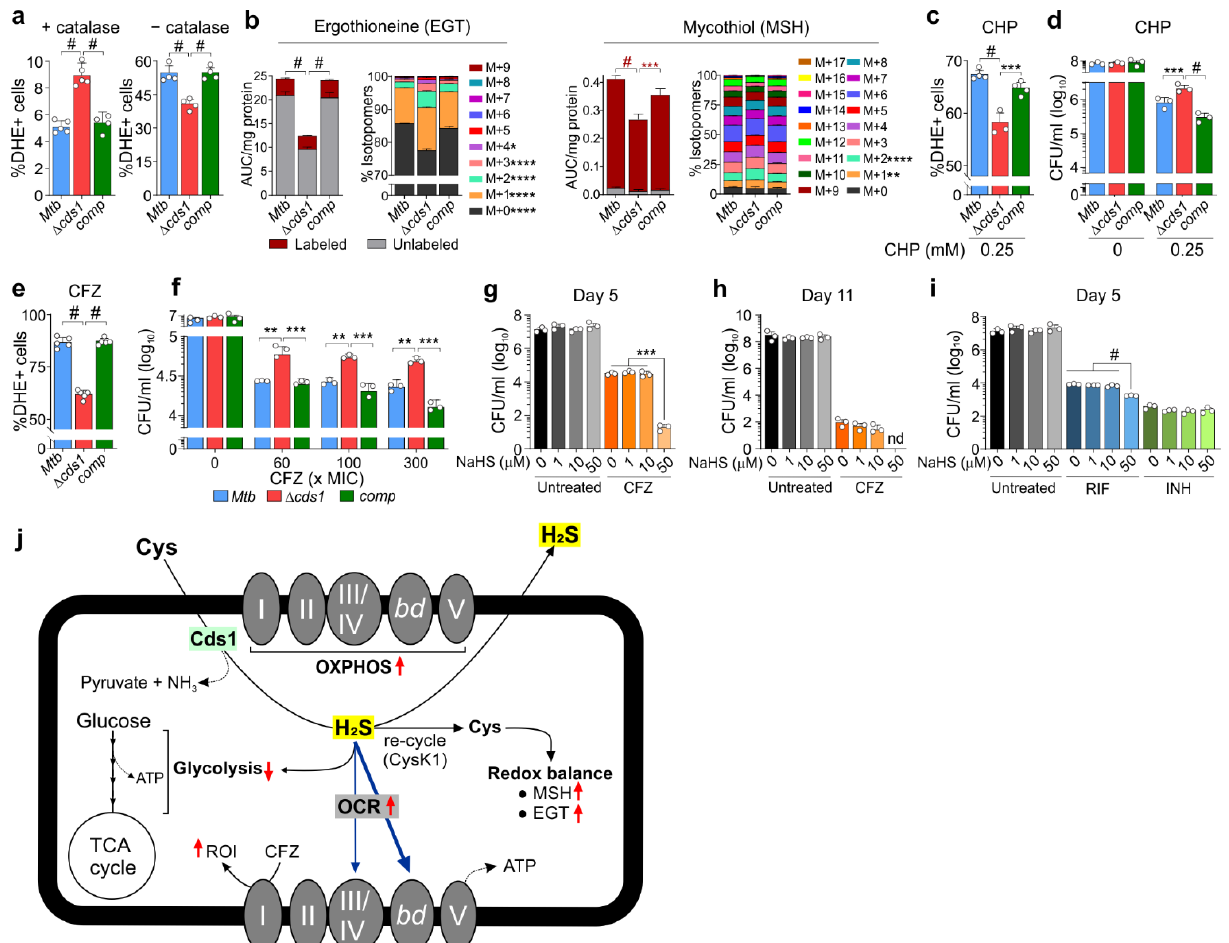
Figure 8. Endogenous H 2 S in Mtb exacerbates the effect of oxidative stress and increases susceptibility to CFZ: ( a ) Intracellular ROI levels shown as the percent of DHE-positive Mtb cultured in 7H9 media supplemented with or without catalase, ( n = 4–5). ( b ) LC-MS/MS analysis showing total abundance and carbon isotopologue distribution of EGT and MSH in Mtb strains cultured in [U- 13 C]-glucose, ( n = 3–5). ( c ) Intracellular ROI levels after exposure to 0.25 mM cumene hydroperoxide (CHP) for 16 h, ( n = 4). ( d ) Survival of bacilli after exposure to 0.25 mM CHP for 16 h, ( n = 3). Bacilli were treated with clofazimine (CFZ) at 60 × MIC and observed for ( e ) ROI levels after 24 h of treatment, ( n = 5) and ( f ) survival after 8 days of treatment, ( n = 3). CFU of Mtb after exposure to different amounts of NaHS with or without 60 × MIC of CFZ for 5 days ( g ) or 11 days ( h ), ( n = 3). ( i ) Survival of Mtb after exposure to different amounts of NaHS with or without RIF (60 × MIC) or INH (60 × MIC) for 5 days, ( n = 3). ( j ) Diagram showing endogenous H 2 S production in Mtb leading to increased respiration (OXPHOS) and suppression of glycolysis. Indicated, also, is recycling of H 2 S to generate Cys, which regulates redox balance via MSH and EGT. Red arrows pointing up: increase; down: decrease. Thick/thin blue arrows: more/less pronounced effects, respectively. Representative experiments are shown; each experiment was repeated at least twice. Data represent the mean ± SD (mean ± SEM for panel ( b )) from the indicated n (number of biological replicates). Statistical analysis and data presentation performed using GraphPad Prism 8.4.3. One-way ANOVA with Tukey’s ( a , e , i ) or Dunnett’s ( c , g , h ) multiple comparisons test were used to determine statistical significance. Two-way ANOVA with Tukey’s multiple comparisons test was used to determine statistical significance for ( b , d , f ). * p < 0.05, ** p < 0.01, *** p < 0.001, **** p < 0.0001, # p < 0.0001; nd = not